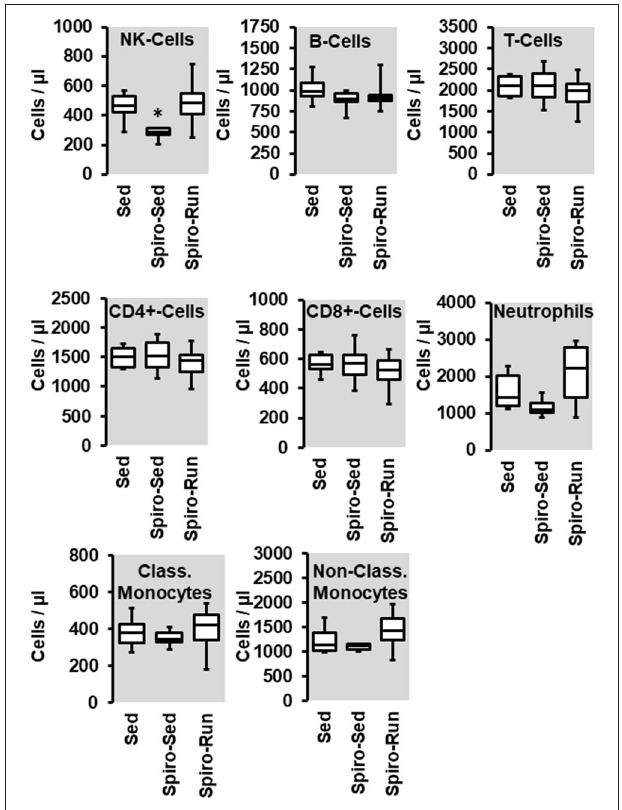
FIGURE 7 | Effect of spironolactone (Spiro) given for the last 4 months and of voluntary running wheel activity (Run) on blood cell concentration in hypertensive rats compared to sedentary controls (Sed). Box plots represent 25, 50, and 75 percentiles with 5 and 95 percentiles given as whiskers. * p < 0.05; One-Way ANOVA with subsequent Student-Newman-Keuls post-hoc analysis.